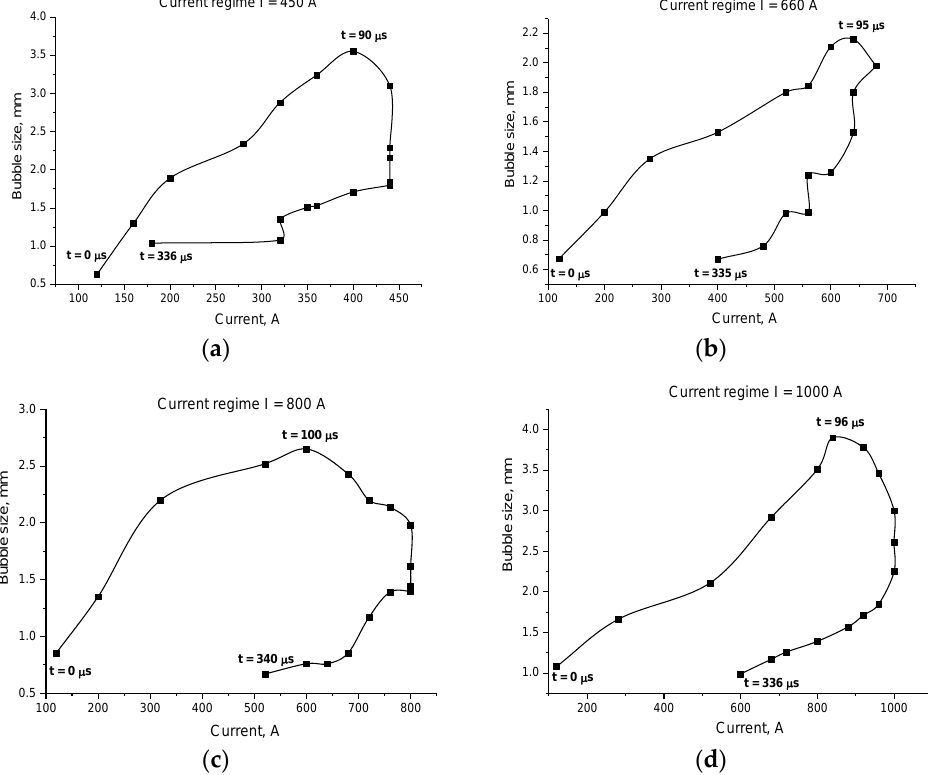
Figure 9. Evolution of the bubble’s size depending on a discharge current (its evolution in time within one pulse) for different values of maximal current: ( a ) for maximal current of 450 A; ( b ) for maximal current of 660 A; ( c ) for maximal current of 800 A; ( d ) for maximal current of 1000 A.